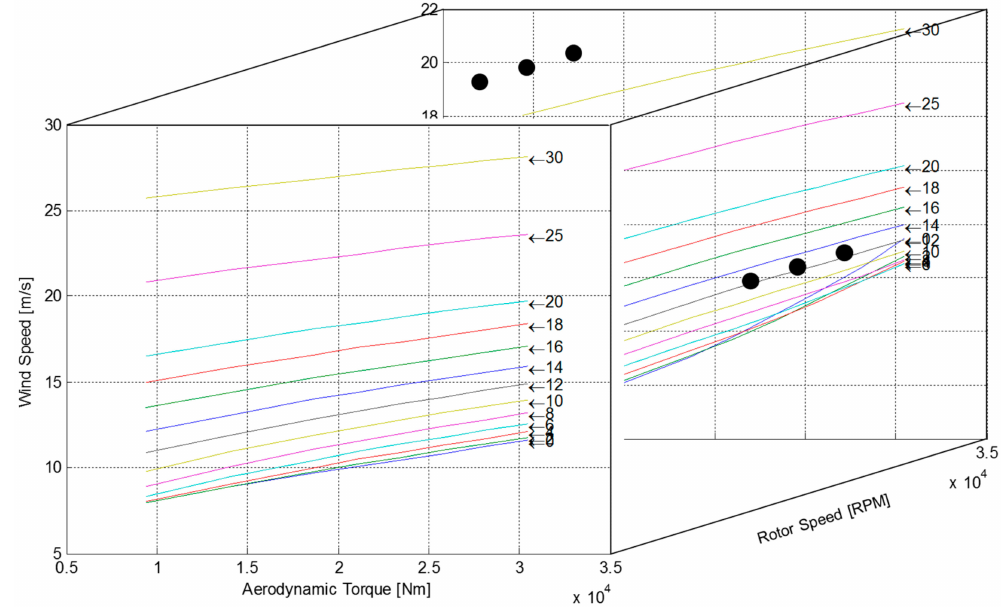
Figure 11. 3D lookup table for the estimated rotor averaged wind